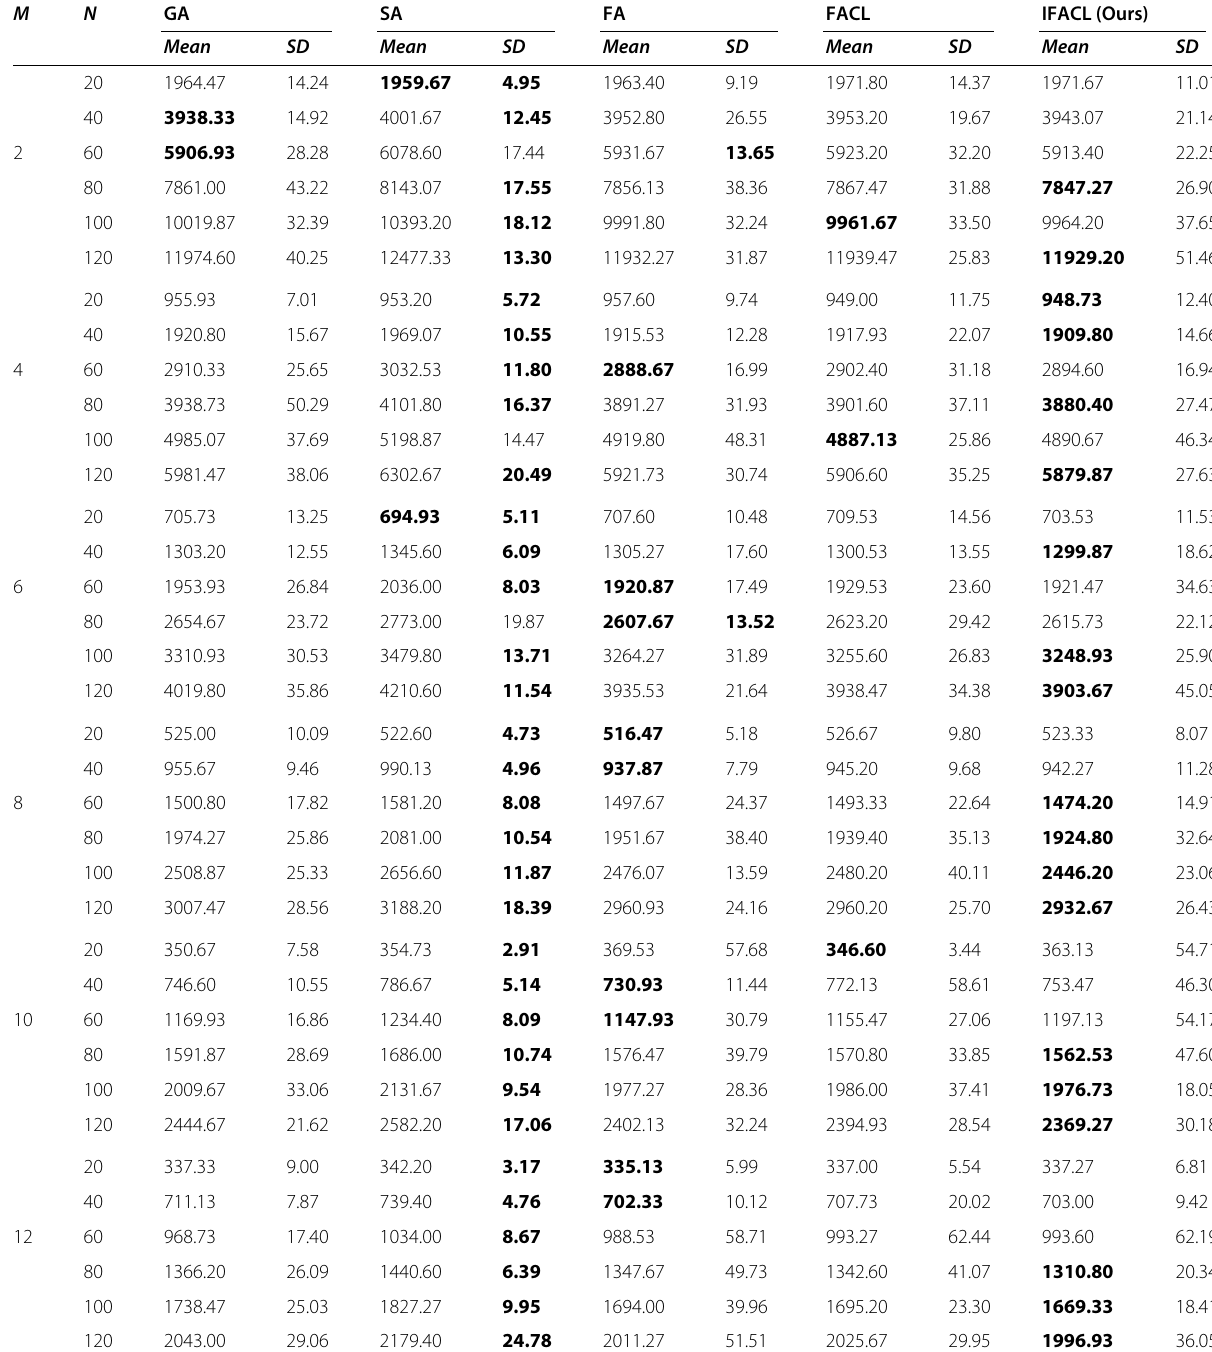
Table 7 Comparison between IFACL algorithm and four comparison algorithms in PDominant instances on